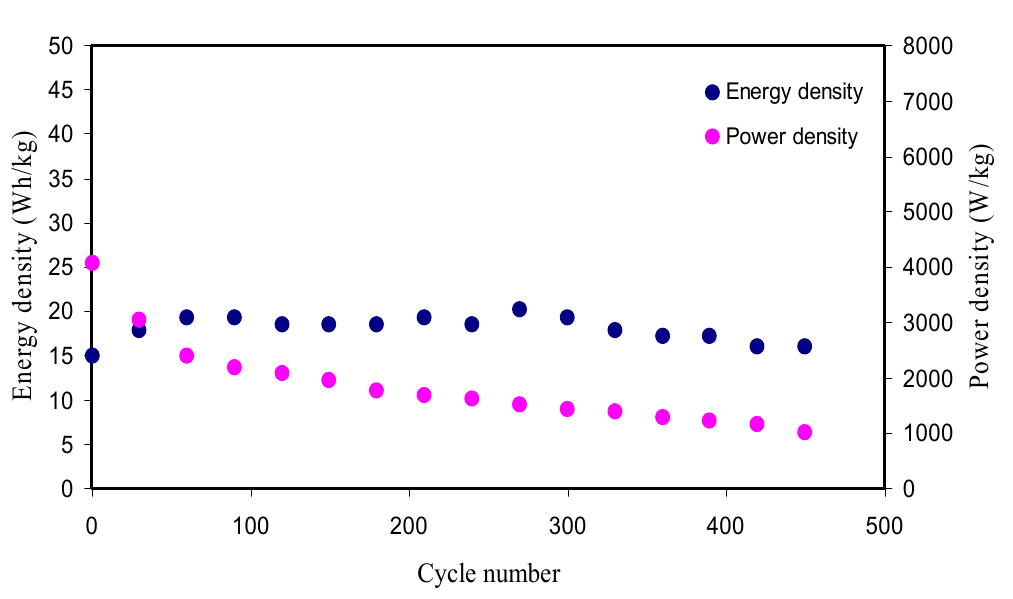
Figure 10. Energy density (E d ) and power density (P d ) of the manufactured EDLC for 450 cycles.